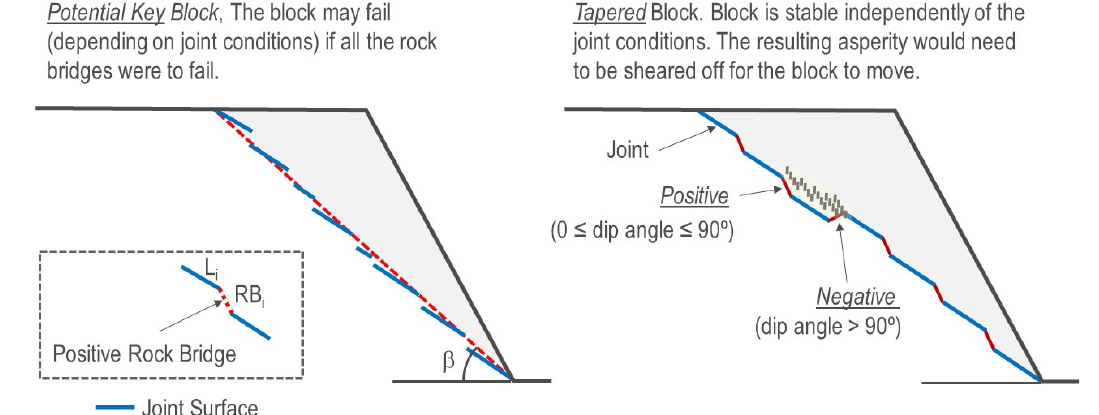
Figure 7. Influence of negative rock bridges concerning block forming potential and block theory definitions of potential key and tapered blocks, raising the importance of rock mass damage over the simple concept of rock bridge percentage.